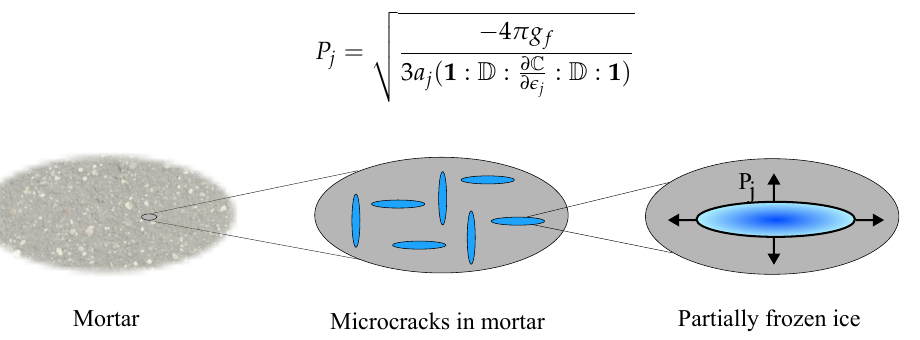
Figure 3. Illustration depicting partially frozen ice generating an internal pressure P j , which leads to microcrack growth. The blue colored inclusions correspond to microcracks that are filled with partially saturated ice and the grey color corresponds to the mortar matrix material. The arrows illustrate the expansive pressure acting on the mortar